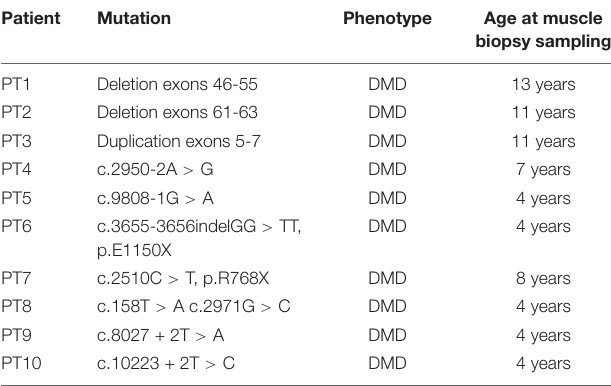
TABLE 3 | Duchenne muscular dystrophy patients selected for expression analysis of the 7 most deregulated genes.